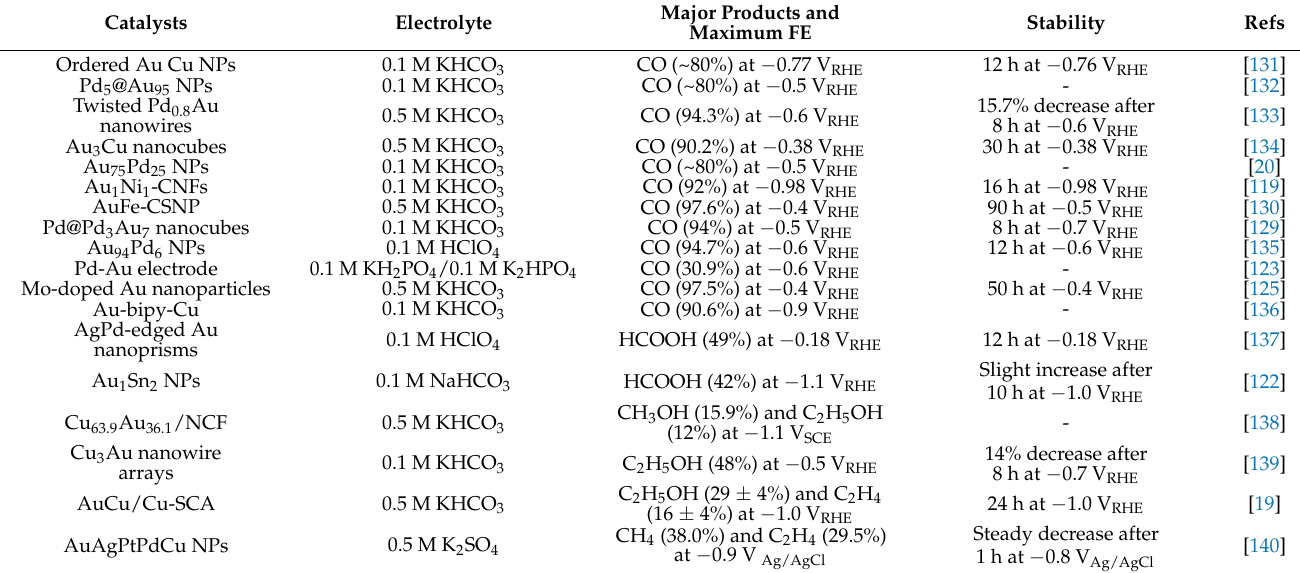
Table 3. Summary of the catalytic performance of representative Au-based nanocatalysts for the CO 2